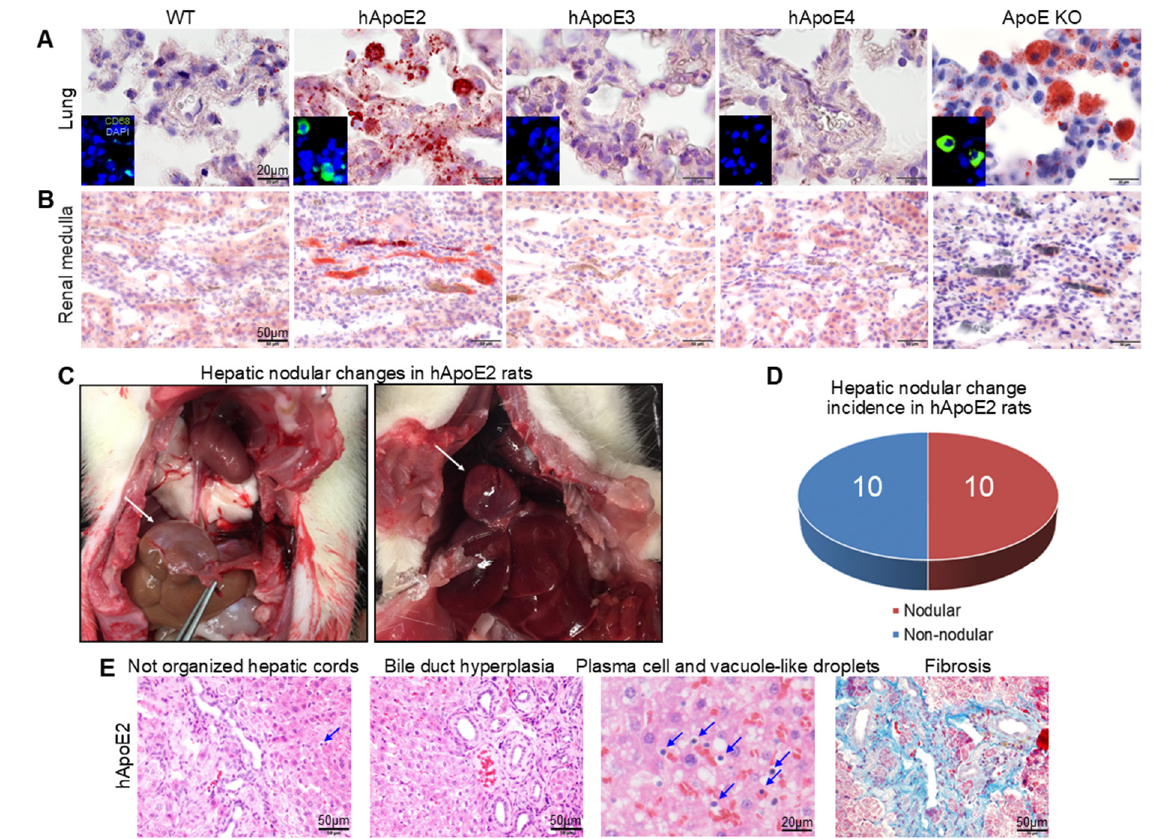
Figure 4. Increased lipid deposition and hepatic nodular cirrhosis in hApoE2 rats. ( A ) Oil Red O staining was used to assess the neutral fat deposit in rat lungs with 8 µm frozen sectioning. Increased Oil Red O-stained cells were detected in the lung tissue of hApoE2 and ApoE KO rats. Anti-CD68 antibody stained these lipid-laden cells. ( B ) Fat deposit in renal medulla was stained by Oil Red O staining. Red blood cells differentiate vessels from tubules in the renal medulla. ( C ) The hepatic nodular tissue of hApoE2 rats was located on the top of the liver and clinging to the diaphragm. Some of the hepatic nodular tissue even bumped into the chest. White arrow indicates the hepatic nodular tissue. ( D ) Incidence of hepatic nodular change in hApoE2 rats is indicated. ( E ) The histological abnormalities in hepatic nodular tissue of hApoE2 showed changes in hepatic nodular cirrhosis, including hepatic cords without the classical radial structure, bile duct hyperplasia, increased plasma cells (blue arrow), vacuole-like droplets (lipid droplets after staining processing), and hepatic fibrosis. The hepatic structure in areas other than nodular change is presented in Figure S1E. Masson staining was used to assess fibrosis, and HE staining was used for the rest of the slides.